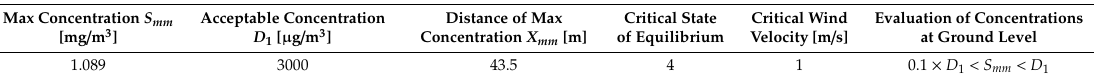
Table 3. Methane (CH 4 ) emissions to the atmosphere during the modelling